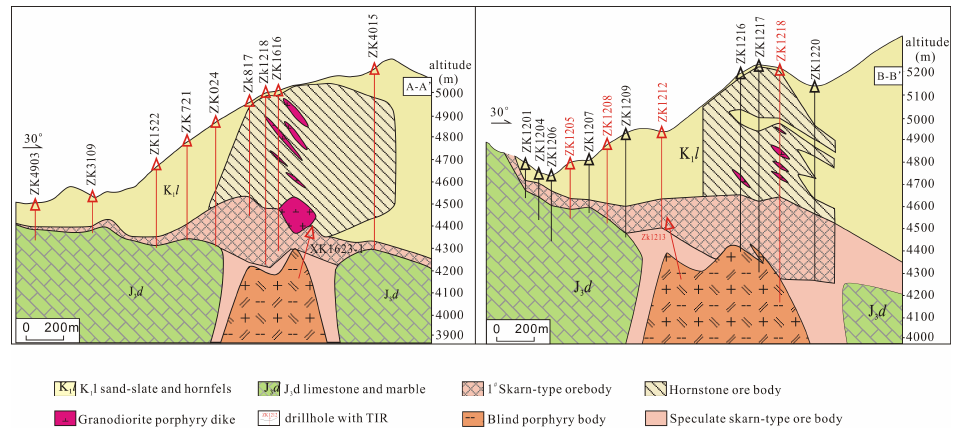
Figure 3. Drillholes with TIR which lie on transect A and transect B. Minerals 2021 , 11 , x FOR PEER REVIEW